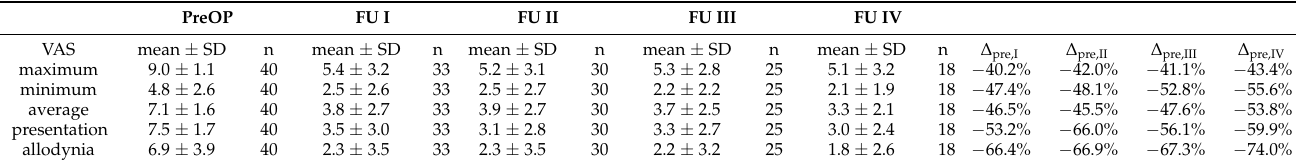
Table 2. Development of specific VAS pain scores during follow-up